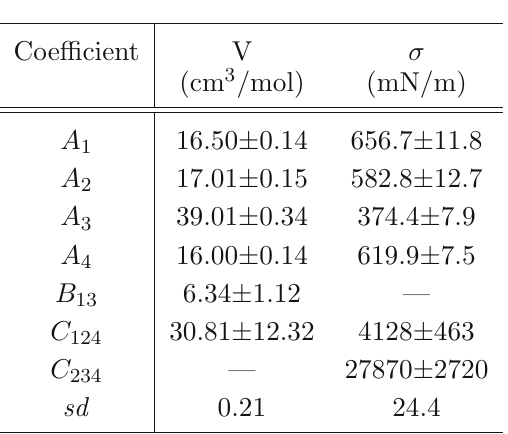
, B , C , and the standard deviations of approximation of the i ij ijk